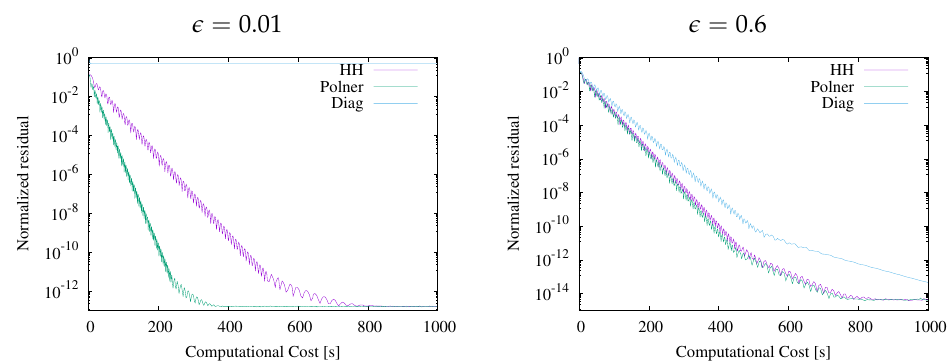
Figure 4. Buoyancy-driven square cavity. Boussinesq model with SGS. Residual convergence for various stabilization matrices